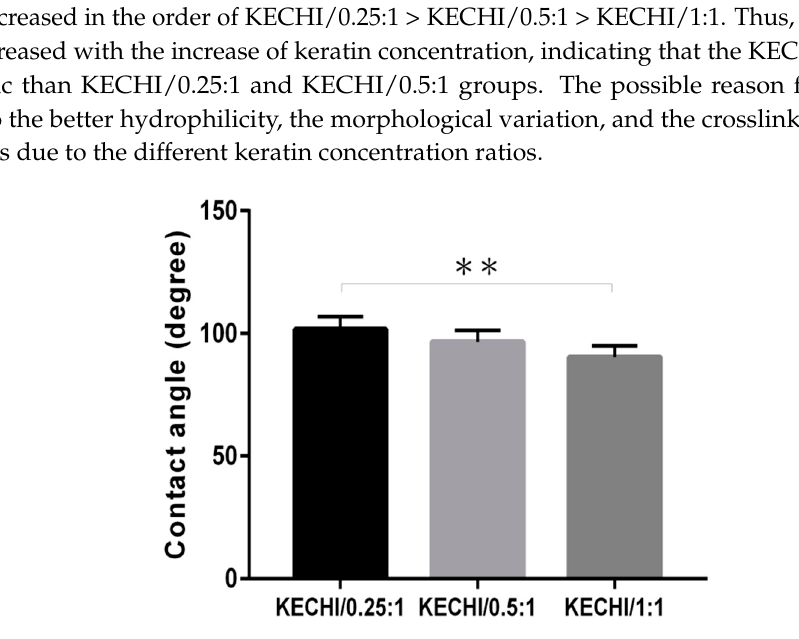
Figure 3. Fluid absorption of keratin-chitosan membranes immersed in pH 7.4 PBS solution.